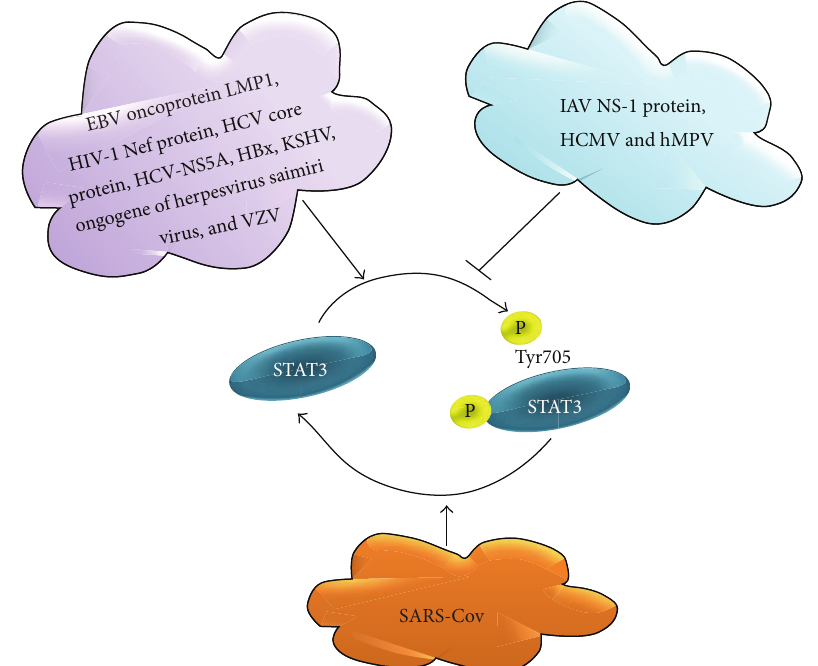
Figure 3: STAT3 regulation in viral infections. Epstein-Barr virus (EBV) oncoprotein latent membrane protein 1 (LMP1), human immunodeficiency virus type 1 (HIV-1) Nef protein, hepatitis C virus (HCV) core protein, HCV nonstructural protein 5A (NS5A), hepatitis B virus X protein (HBx), Kaposi’s sarcoma-associated herpesvirus (KSHV), saimiri transforming protein (STP) oncogene of Herpesvirus saimiri subgroup A strain 11 (STP-A11), and Varicella-zoster virus (VZV) activate STAT3 phosphorylation. Influenza A virus (IAV) nonstructural protein 1 (NS-1) human metapneumovirus (hMPV) and human cytomegalovirus (HCMV) inhibit STAT3 phosphorylation. Severe acute respiratory syndrome coronavirus (SARS-CoV) infection results in STAT3 dephosphorylation.